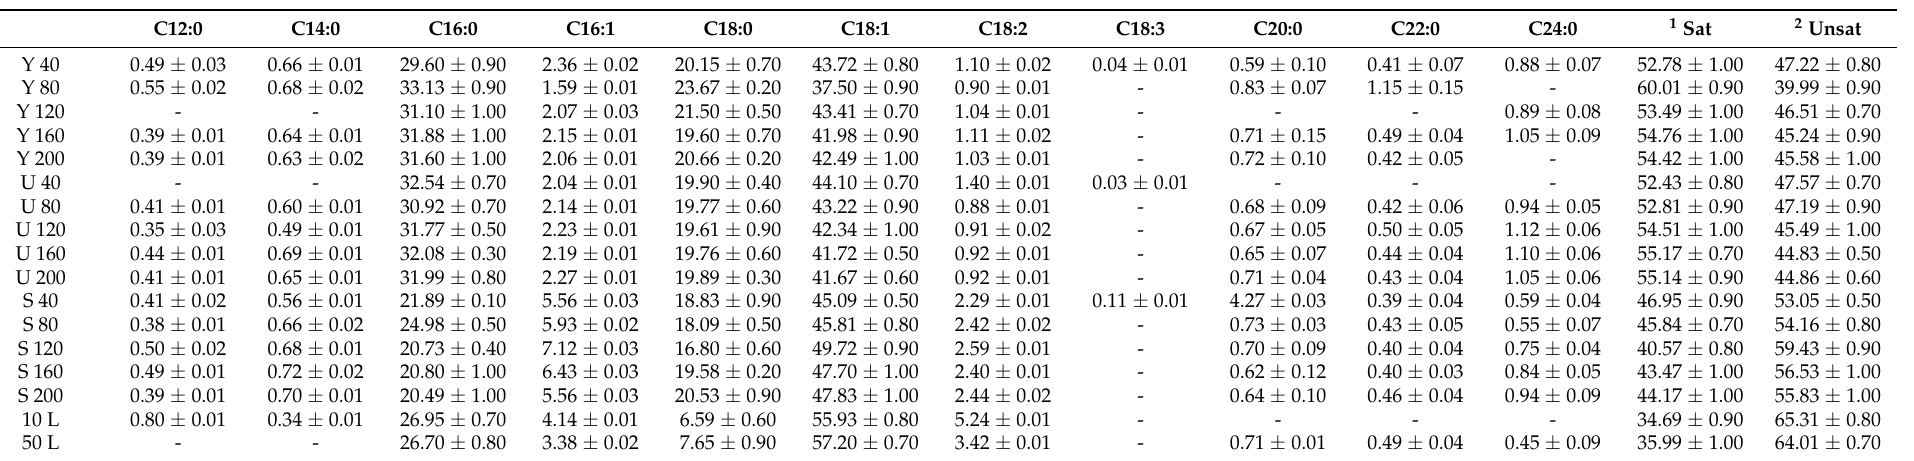
Table 8. Main FAs produced by L. tetrasporus DSM70314, in bench scale and bioreactor (10 and 50 L) from steam-pre-treated wheat straw in 3 different nitorgen sources, Yeast extract (Y), Urea (U), and Soy flour (S), and 5 different C/N ratios: 40, 80, 120, 160, and 200, respectively. The values have been normalized and correspond to % of the total FAs